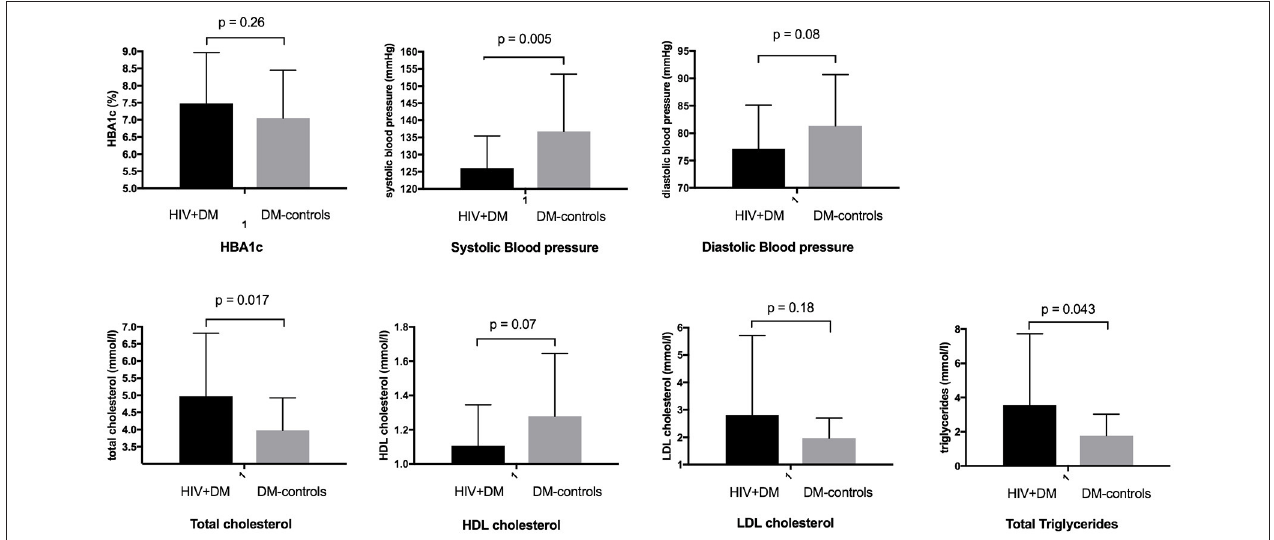
FIGURE 1 | Diabetic care benchmarks in diabetes clinic attendees with HIV-infection compared to controls.